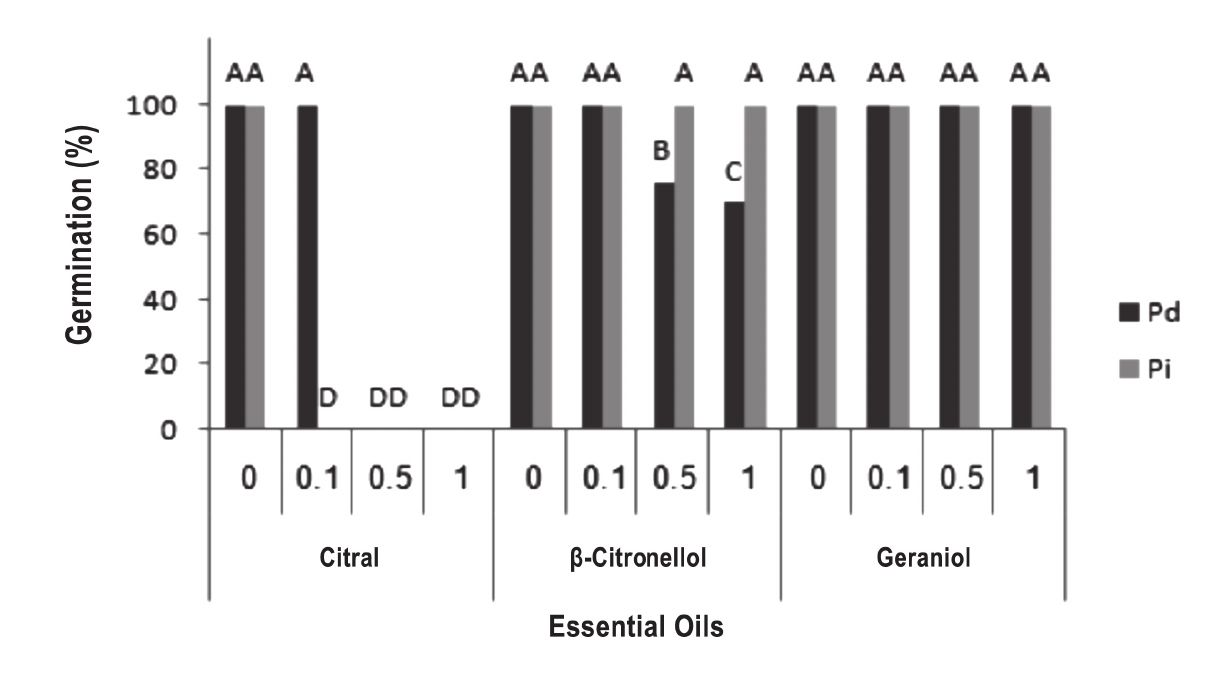
Figure 4. Mean percentage spore germination (fumigant effect) of Penicillium italicum (Pi) and P. digitatum (Pg) exposed to different essential oils. Bars followed by the same letter are not signi fi cantly different ( P ≤ 0.1%), Duncan’s Multiple Range Test.